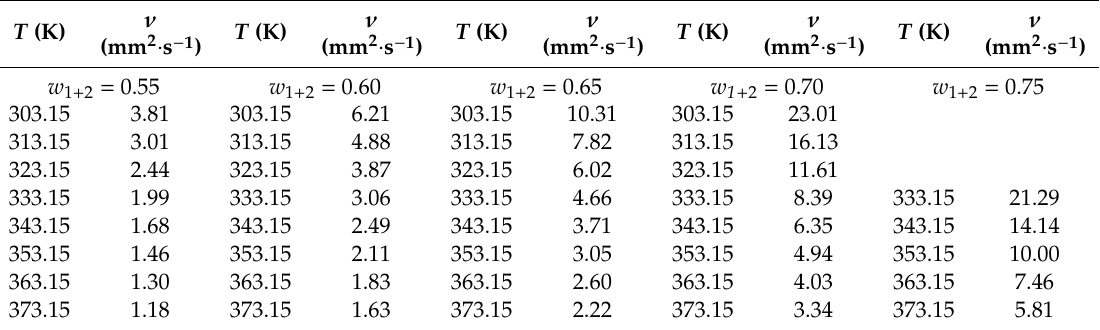
Table A5. Viscosity at absorbent mass fraction w of the system LiBr (1) + [BMIM]Cl (2) + H 2 O (3) at p = 0.1 MPa a